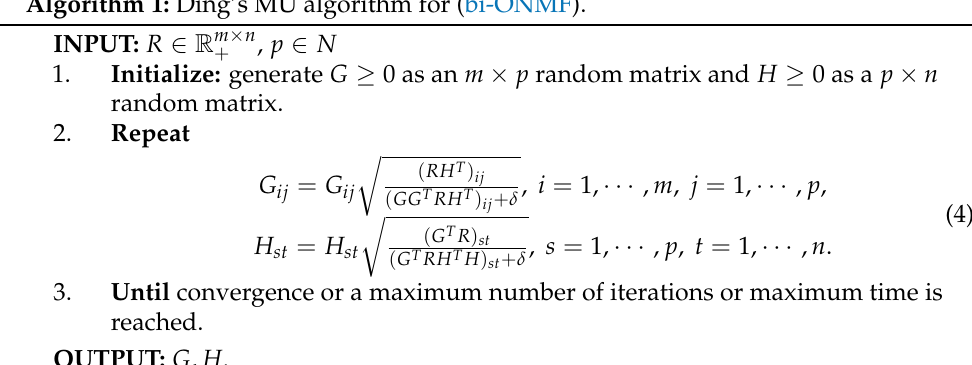
Algorithm 1: Ding’s MU algorithm for